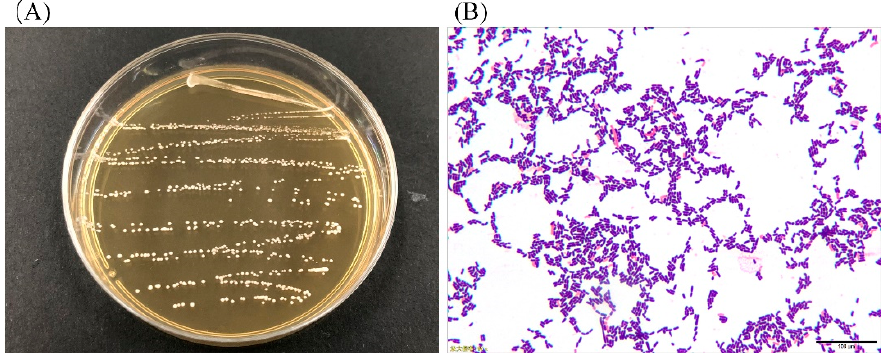
Figure 1. Colony morphology ( A ) and cell morphology ( B ) of the strain.